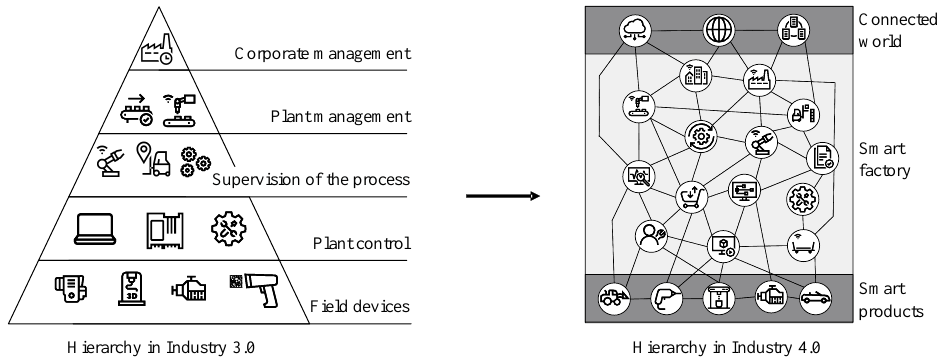
Figure 1. Hierarchy changes from Industry3.0 to I4.0 according to